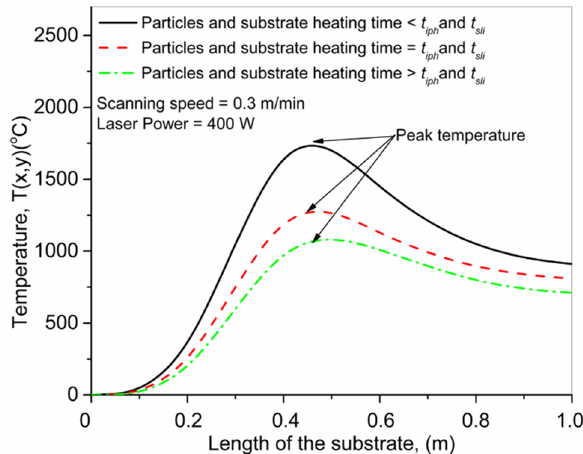
Figure 9. Influence of particles’ and substrate’s heating times on temperature of the substrate for Ti6Al4V alloy deposition.